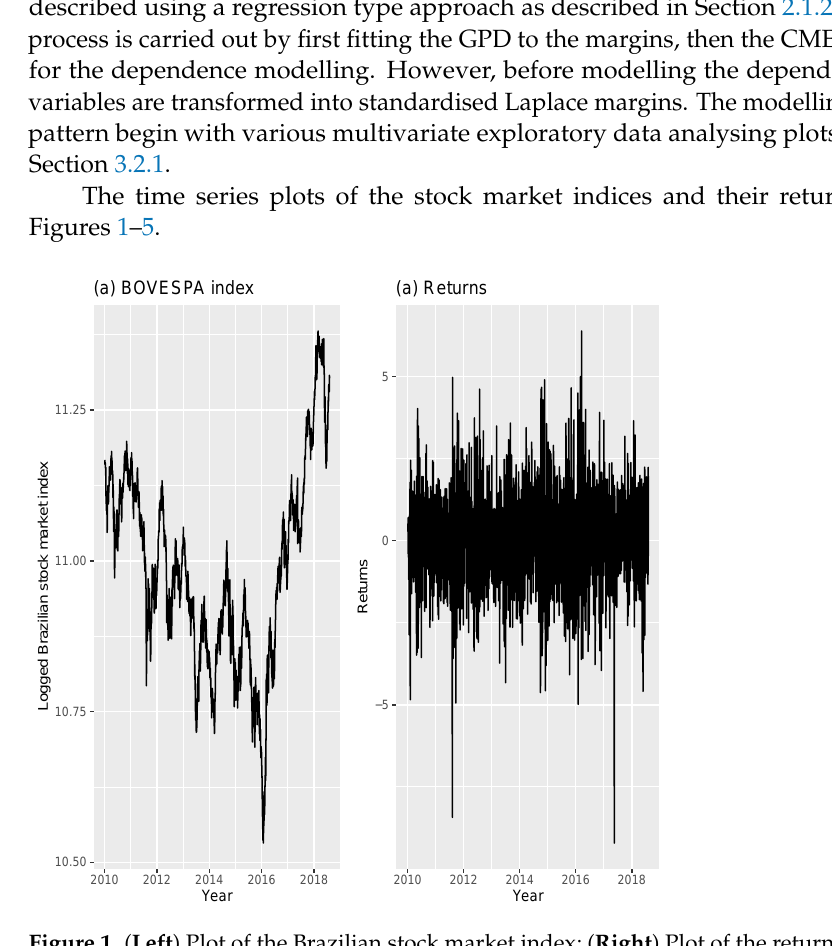
Figure 1. ( Left ) Plot of the Brazilian stock market index; ( Right ) Plot of the